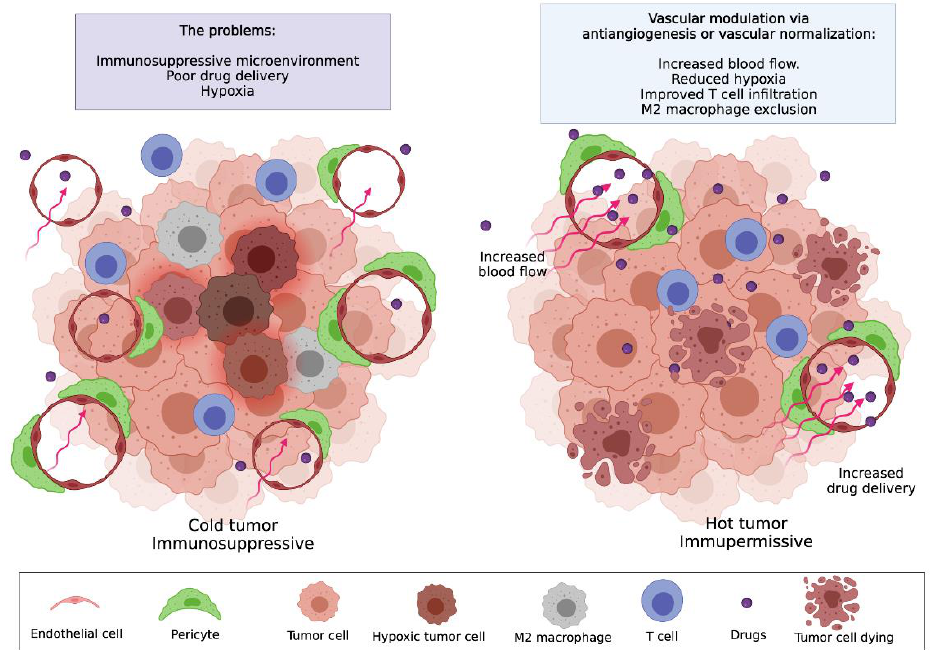
Figure 2. Modulating tumour vasculature to enhance immunotherapy efficacy. Immune checkpoint blockade is not effective in many cancer types due to the hypoxic immunosuppressive tumour microenvironment including endothelial cells of tumour blood vessels. Anti-angiogenic therapy reduces blood vessel density and some of the immunosuppressive effects of tumour angiogenesis. Anti-angiogenesis and vascular normalisation, using low dose anti-angiogenic drugs, reduces the immunosuppressive tumour microenvironment by increasing blood flow, and drug delivery and reducing subsequent hypoxia, making favourable conditions for the infiltration of CD8+ cells and allowing the effectiveness of immune checkpoint blockade. Created with BioRender.com .